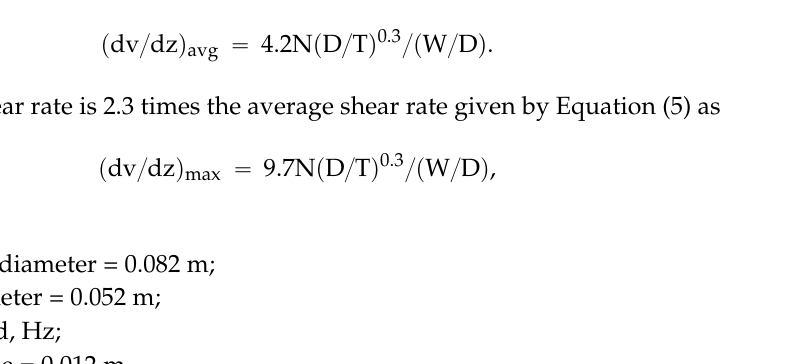
Figure 7. Effect of Impeller Speed on organic sulphur removal.